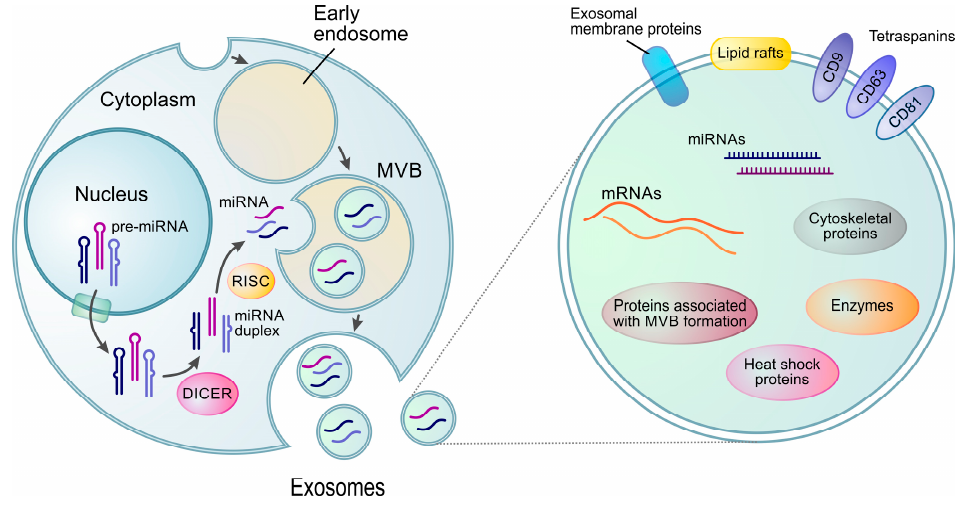
Figure 2. Extracellular vesicles—the production and contents of exosomes.